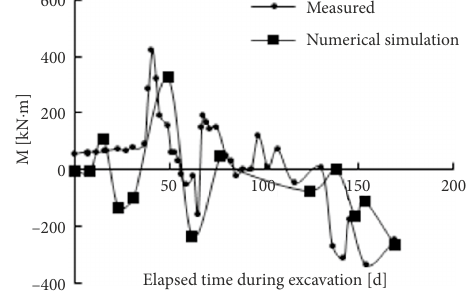
Figure 11. Comparison of the bending moments at monitoring points (3)–(C)